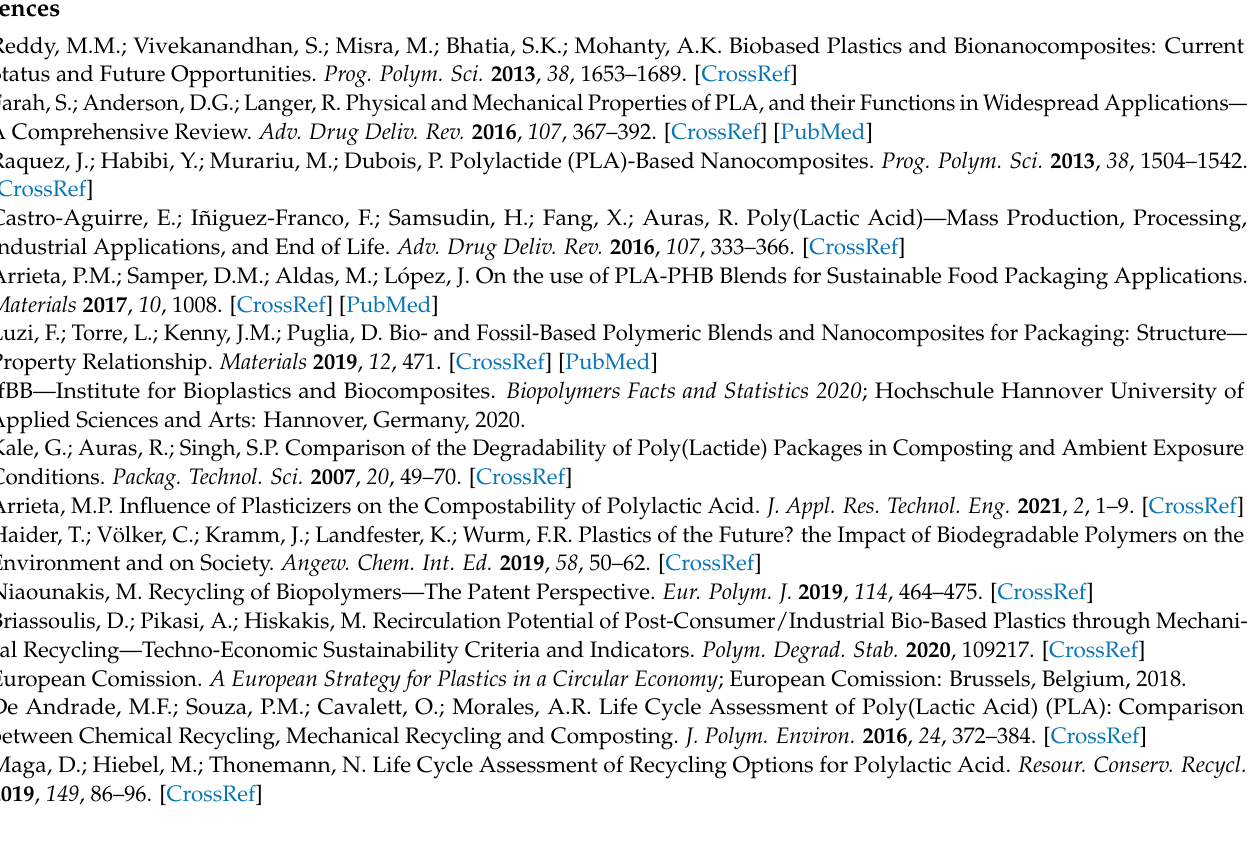
( b ) TEM image of YMNs powder; Figure S2: ( a ) DLS measurements of SFNs and ( b ) TEM image of SFNs powder and Figure S3: FE-SEM images of: PLAV ( a ), PLAR ( b ), and nanocomposites: PLAR loaded with 1% wt. of YMN ( c ) and PLAR loaded with 2% wt. of SFN ( d